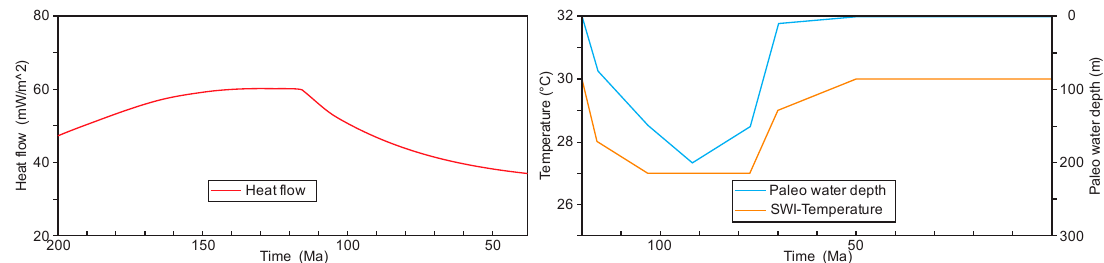
Figure 15. Boundary conditions used for 1D modeling of burial history of the lithological units in the ANH-CARRETALITO-1 and ANH-CAÑABOBA-1 wells.